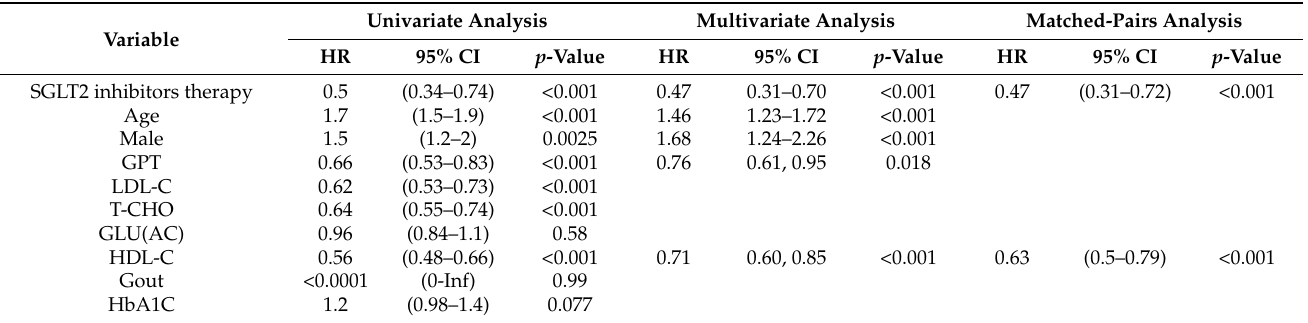
Table 6. Univariate and multivariate analyses of myocardial infarction incidence in the study patients.